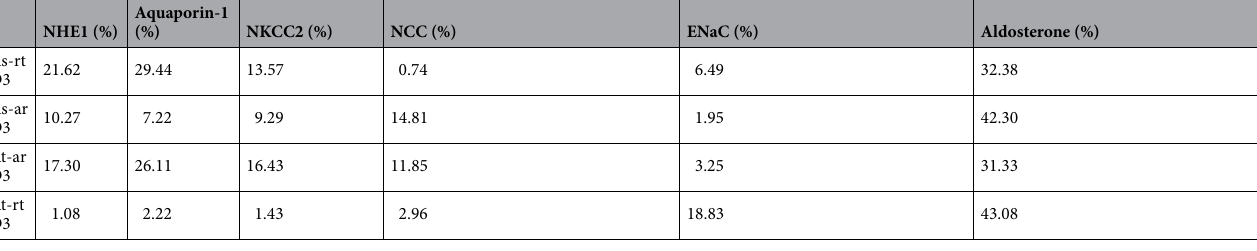
Table 2. % decrease in mRNA expression of renal transporters and plasma aldosterone upon treatment with the highest tested dose of each extract compared to positive control group. As: Astragalus spinosus , At: Astragalus trigonus , ar: aerial organs, rt: root organs, D3: high dose, NKCC 2: Na–K-Cl co-transporter 2, NCC: sodium-chloride symporter, NHE1: sodium–hydrogen antiporter 1 and ENaC: epithelial sodium